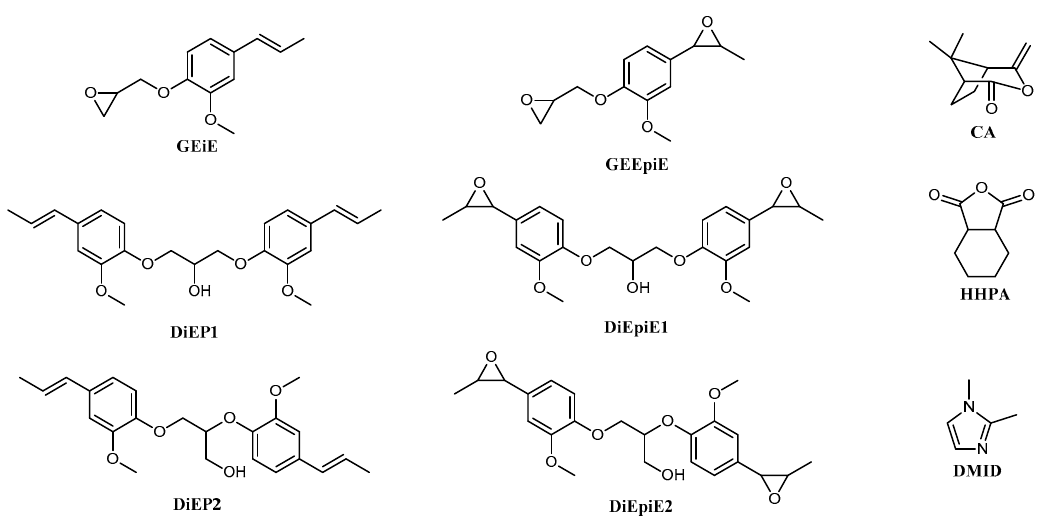
Scheme 1. Molecular representations of reagents used in the resin manufacturing process. Left: